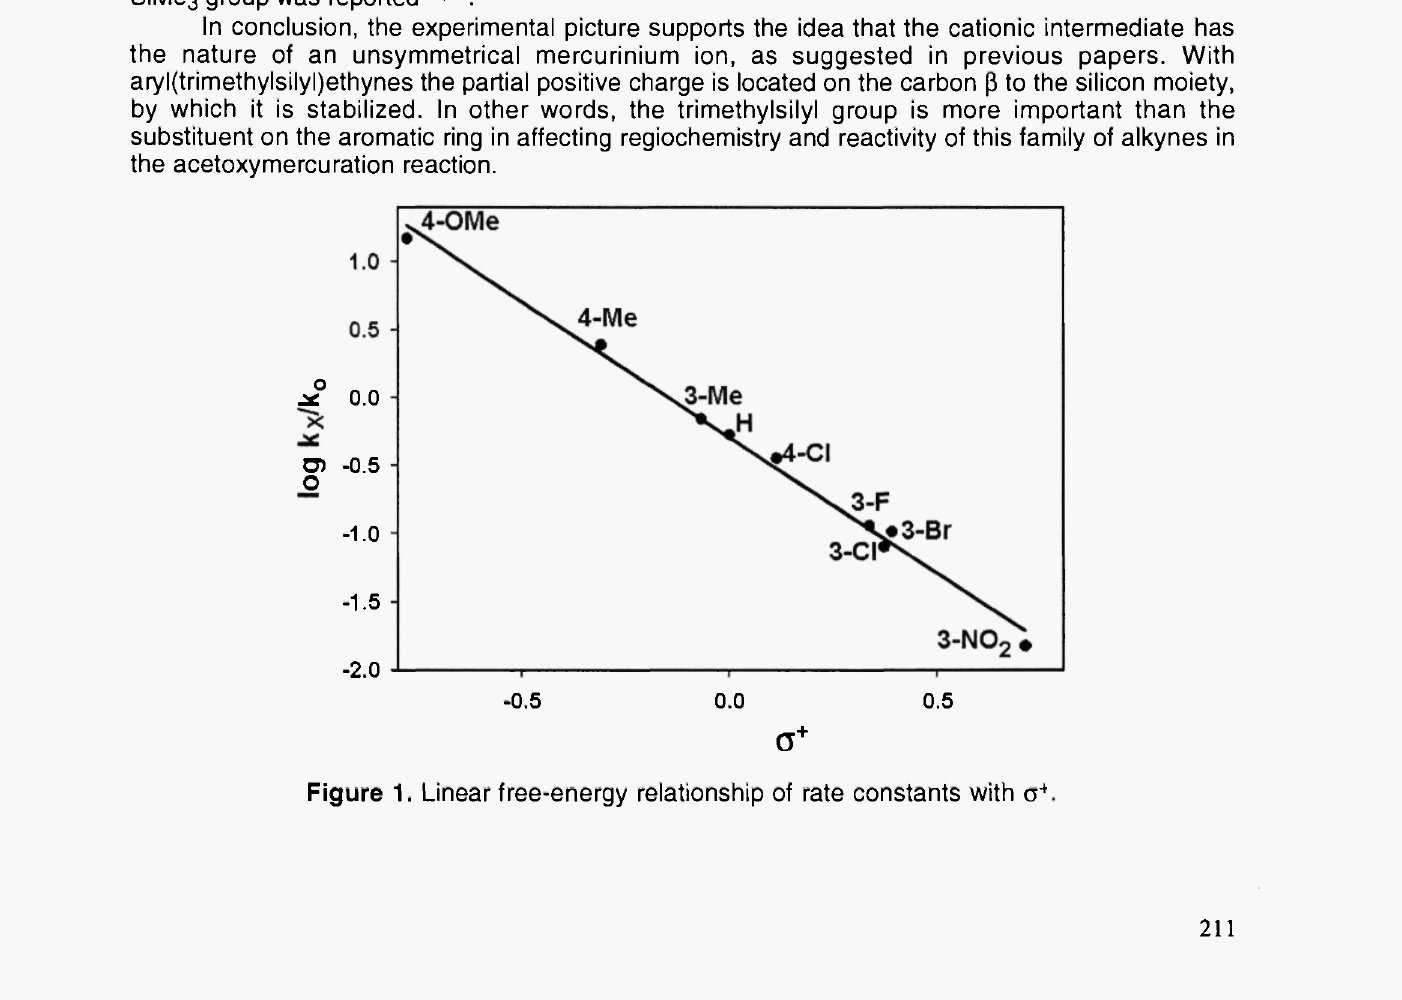
1. Linear free-energy relationship of rate constants with σ